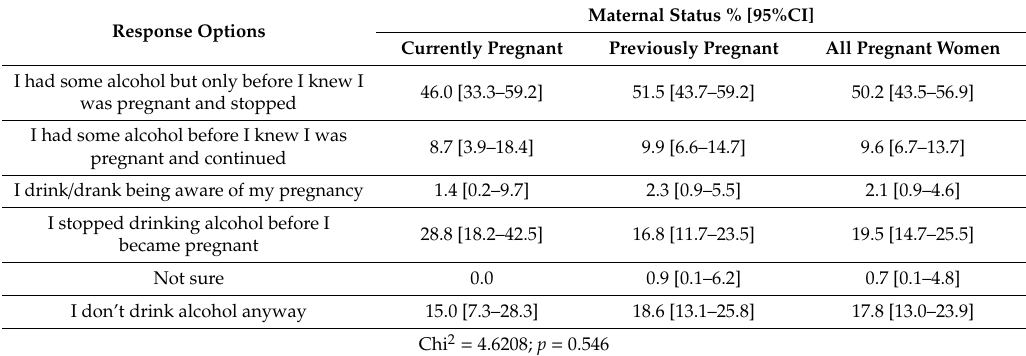
Table 2. Alcohol consumption in pregnancy among currently pregnant women ( n = 62) 1 and previously pregnant women ( n = 201) 2 .